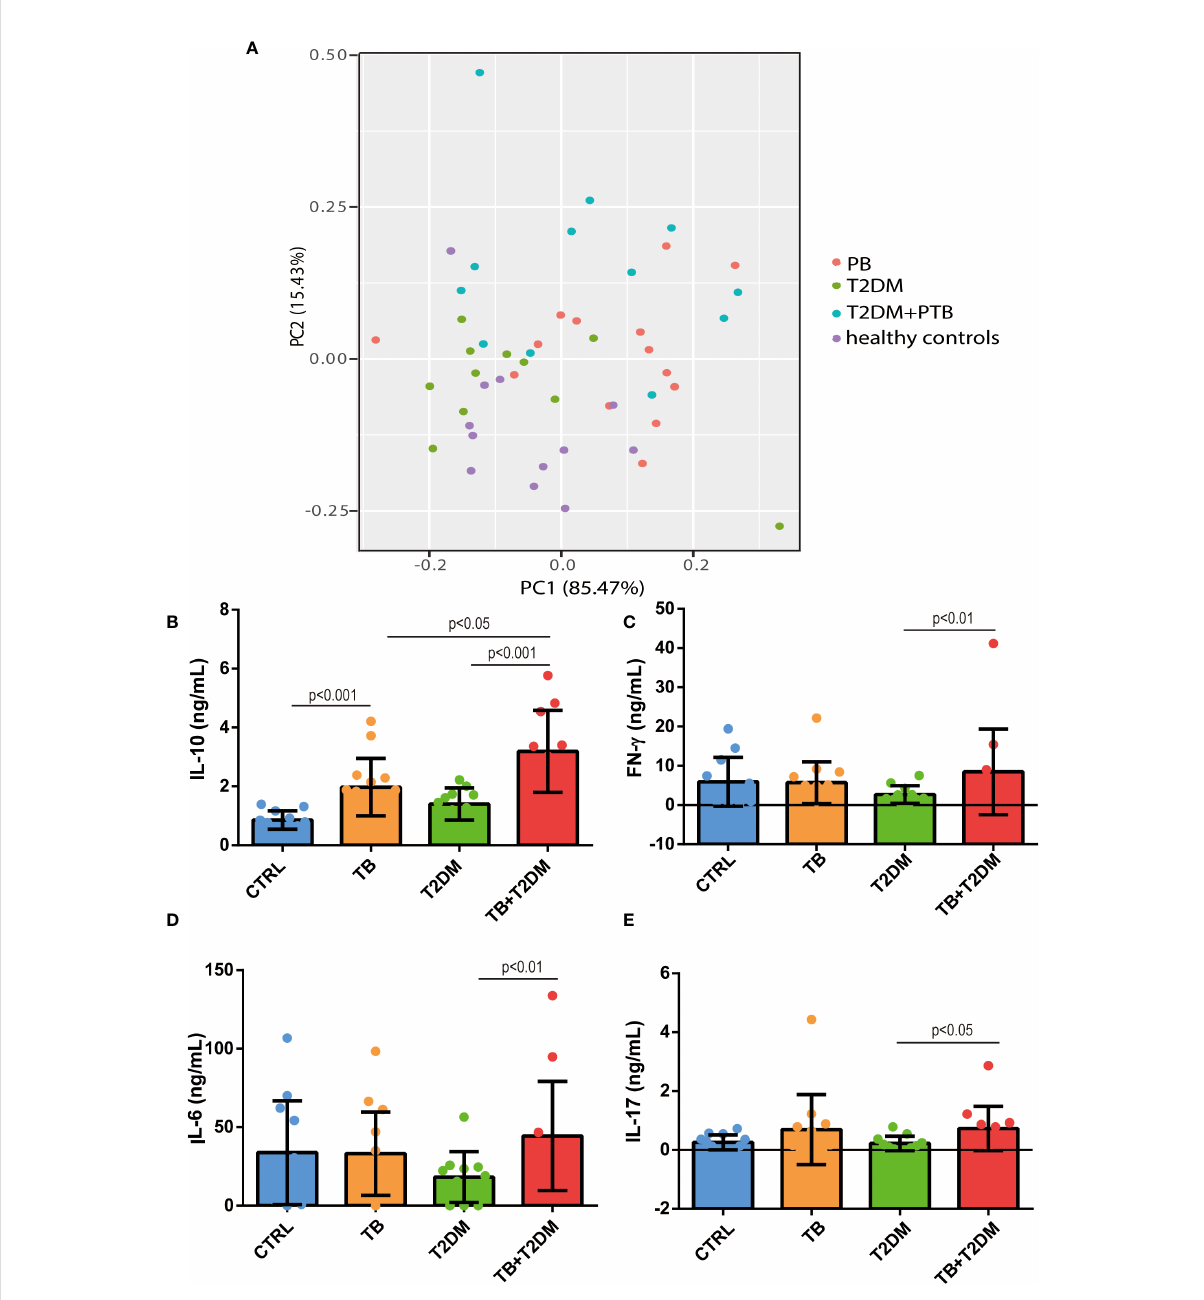
FIGURE 3 Serum levels of IL-10, IL-6, IL-17 and IFN-gamma among all groups. (A) PCA plot. (B – E) serum levels of IL-10, IFN- g , IL-6 and IL-17 in the study subjects. CTRL, healthy controls; PTB, pulmonary tuberculosis; T2DM, type 2 diabetes mellitus; PTB+T2DM, pulmonary tuberculosis combined with type 2 diabetes